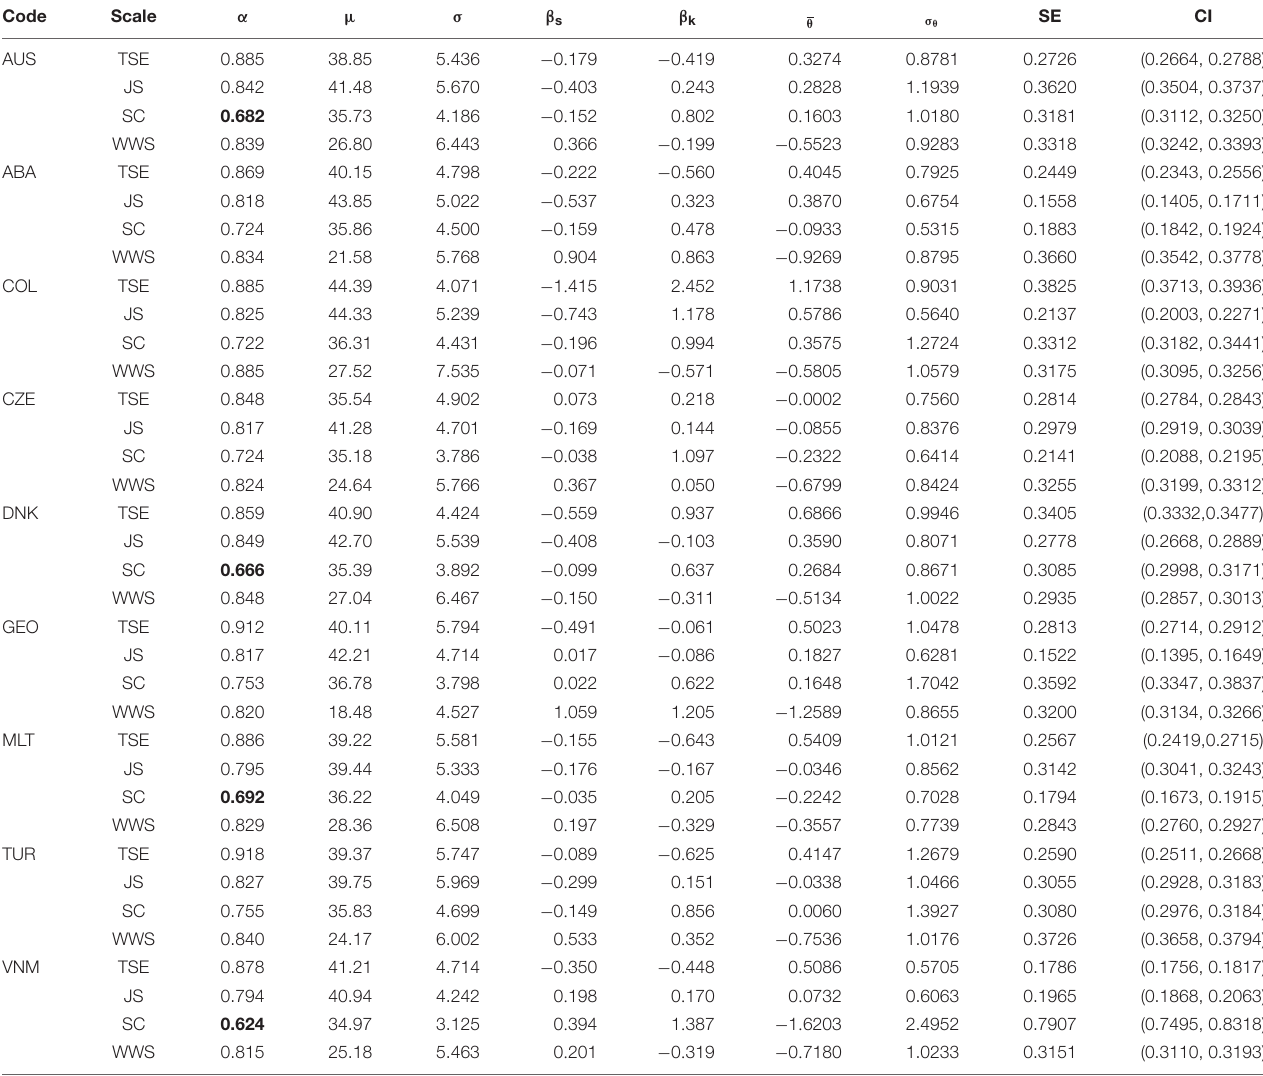
TABLE 2 | Reliability index, descriptive statistics of total scores, and latent traits.